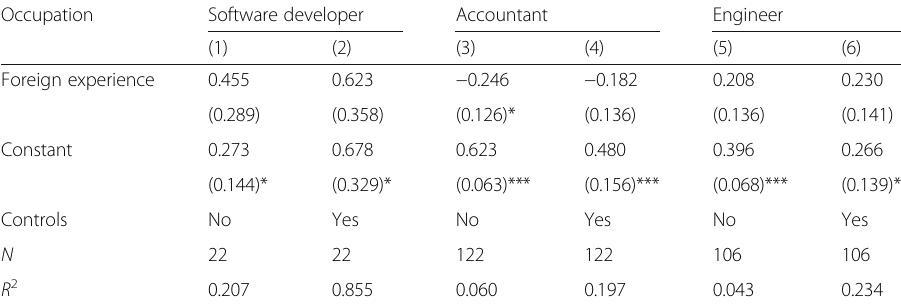
Table 7 Dependent variable: if a resume receives a callback conditional on employers that call back one applicant out of two Occupation Software developer Foreign